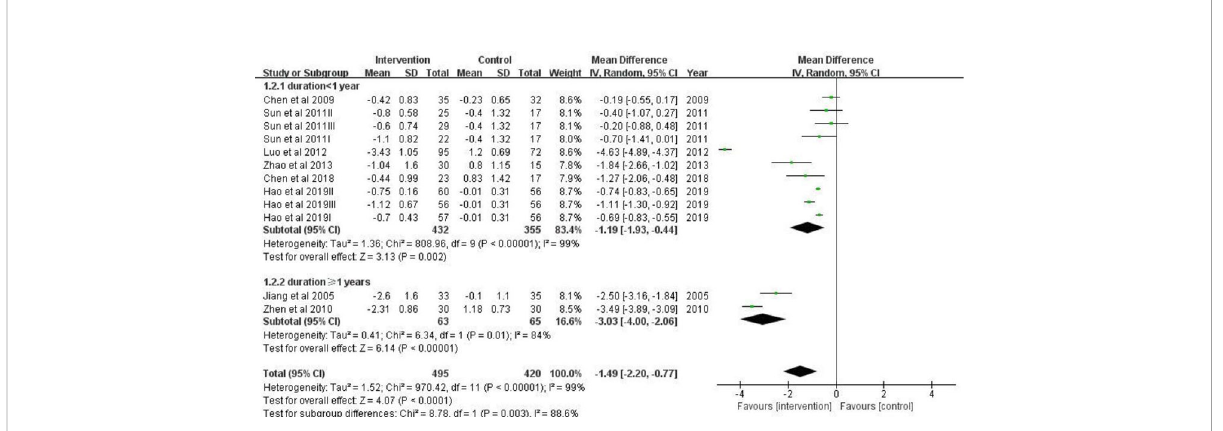
FIGURE 5 A forest plot providing data on the impact of lifestyle interventions on BMI with 95% con fi dence intervals of individual studies, grouped by duration of intervention. Using a random effects model and an inverse variance method, a summary estimate of the 95% con fi dence interval was calculated. SD, standard deviation; IV, inverse variance; CI, con fi dence interval.